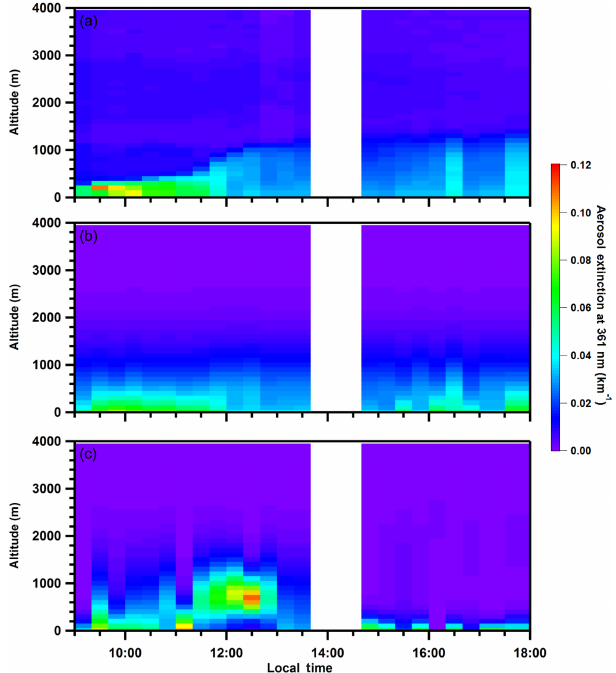
Figure 17. The 6 September vertical profiles of aerosol extinction (361nm) from averaged lidar (a) , smoothed lidar (b) , and MAX- DOAS retrieved measurements (c) .